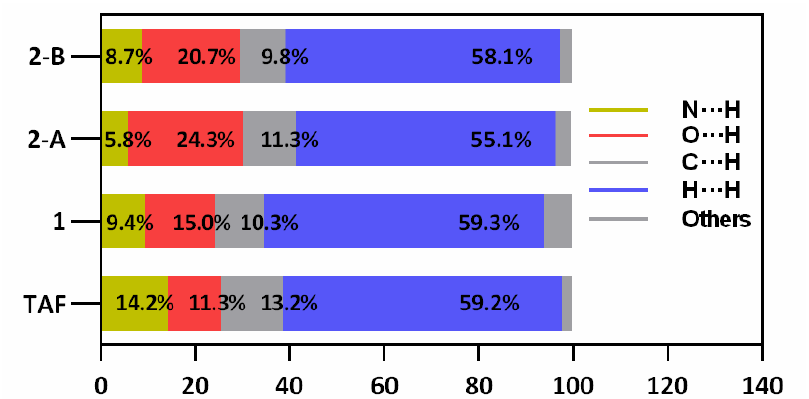
Figure 9. Relative ratios of the contributions of different interactions to the Hirshfeld surface for TAF, 1 , and two TAF-fumarate pairs in 2 (denoted as 2 -A and 2 -B), showing that the presence of water molecules in 2 greatly raises the relative contribution of O∙∙∙H/H∙∙∙O amongst the collection of interactions.